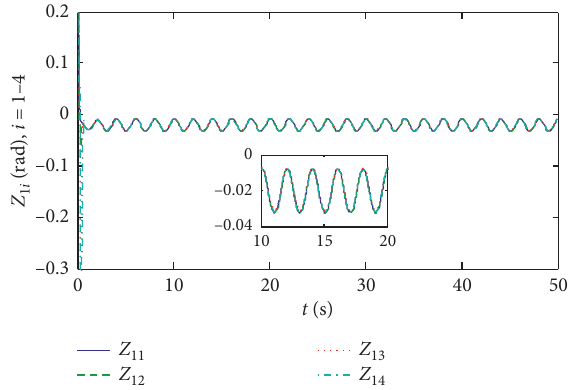
Figure 17: The auxiliary variables Z